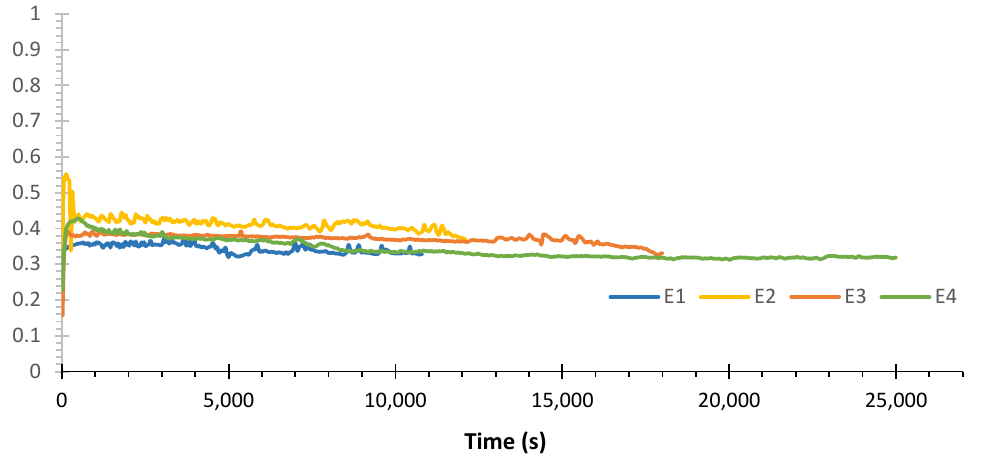
Figure 7. Coefficient of Friction (COF) curves for the tests performed for the system WC-Co/100Cr6.